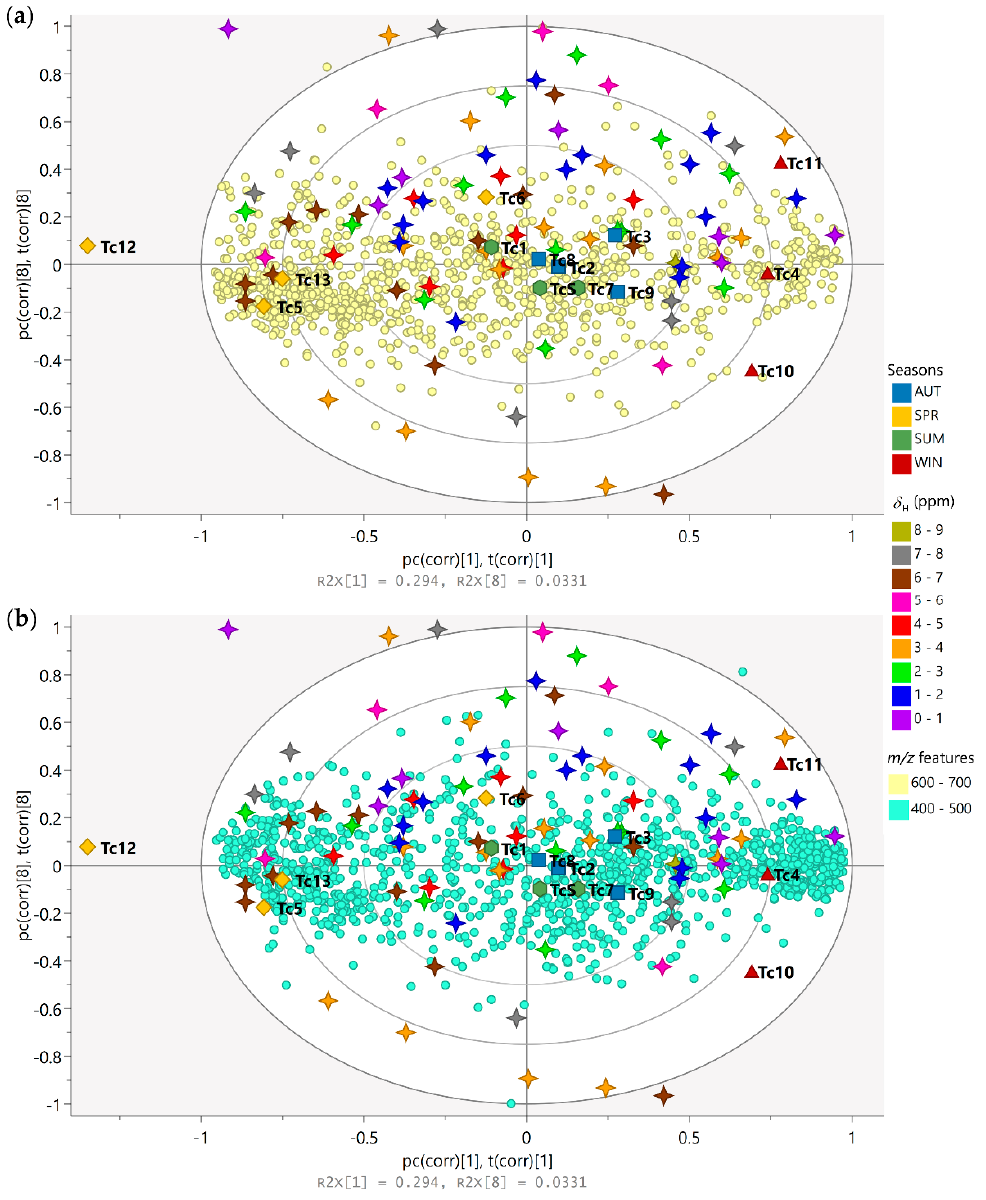
Figure 4. Biplot (loadings p and scores t) based on PLS-DA model describing the simultaneous correlation between the chemical variables ( m / z features and 1 H NMR chemical shifts) and the grouping of samples (seasonal harvests). Season samples are represented by hexagon—Summer (SUM: Tc1, Tc7, and TcS), square—Autumn (AUT: Tc2, Tc3, Tc8, and Tc9), triangle—Winter (WIN: Tc4, Tc10, and Tc11), and diamond—Spring (SPR: Tc5, Tc6, Tc12, and Tc13); m / z features by circles (( a ) 400 to 500 and ( b ) 600 to 700 Da); 1 H NMR chemical shifts ( δ ) by 4-point stars (0.0 to 9.0